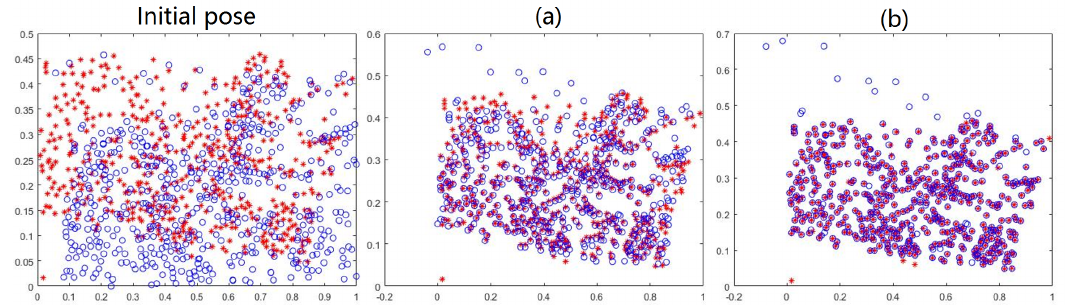
Figure 8. Examination of the availability of the MGMM. Red ∗ : the target feature point set X . Blue ◦ : the source feature point set T ( Y ) . ( a , b ) registration result of GMMREG and our method. Obvious deviation exists in the result of